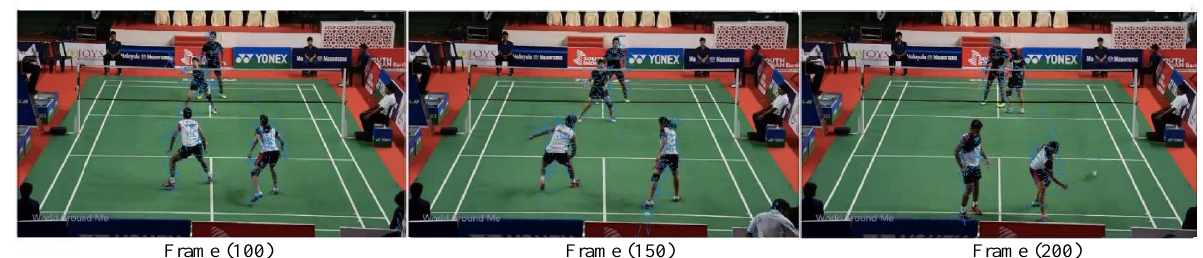
Figure 10. Simulation results from video dataset 4 by the proposed framework (( a ) extracted frames in grayscale, ( b ) foreground by adaptive background subtraction post-binarization and ( c ) optical flow).